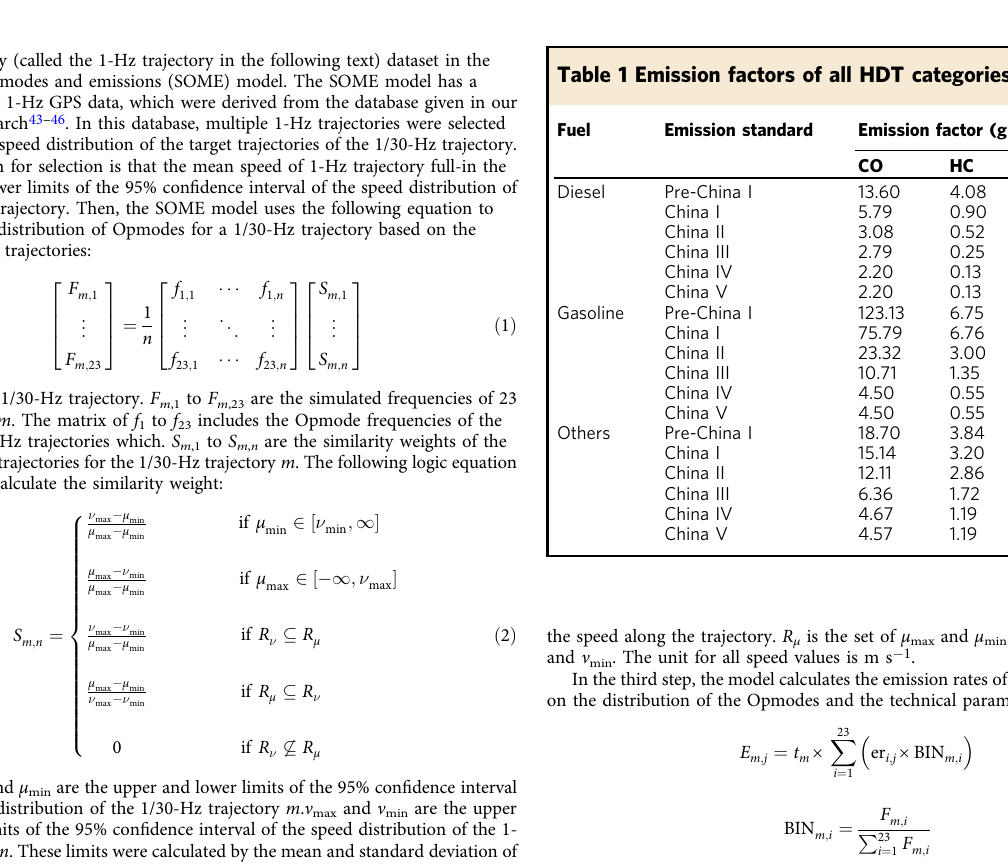
Fig. 7 The TrackATruck framework for the HDT emission calculation used in this study. Step 1 is to convert HDT BDS data to the trajectories. One trajectory contains multiple continuous BDS data. Step 2 is to calculate the distribution of the operating modes for each trajectory, and Step 3 is to calculate the emissions for each trajectory. The simulated operating modes and emissions model is used to simulate the distribution of the operating modes by speed distribution of a trajectory and calculate emissions based on the emission rates of the operating modes. Step 4 is to aggregate that HDT emissions by all HDT trajectories, combining with various maps, e.g. provincial border, to the temporal-spatial characteristics.